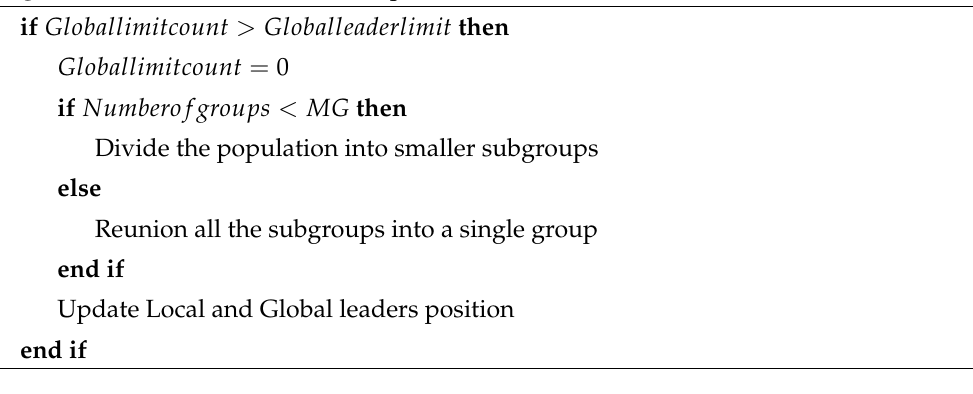
Algorithm 4 Global leader decision